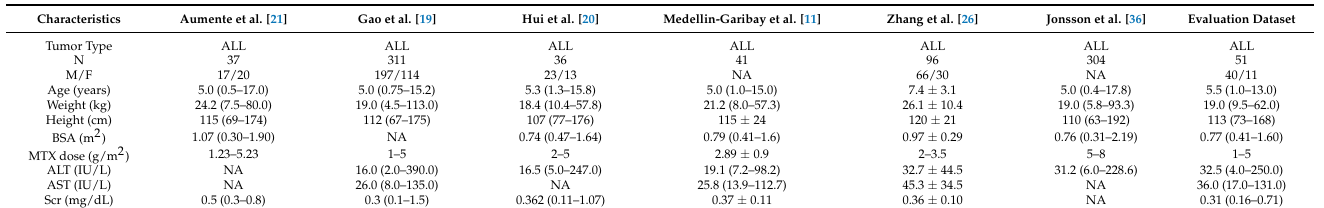
Table 1. Demographics and clinical characteristics of the included studies and evaluation dataset of high-dose methotrexate in children with acute lymphoblastic leukemia